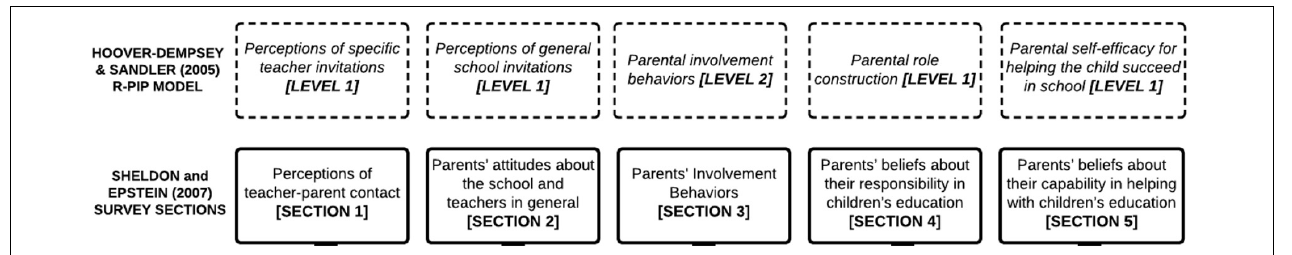
FIGURE 2 | Mapping of Hoover-Dempsey and Sandler (2005) R-PIP model in top row, Sheldon and Epstein (2007) survey section in top row.